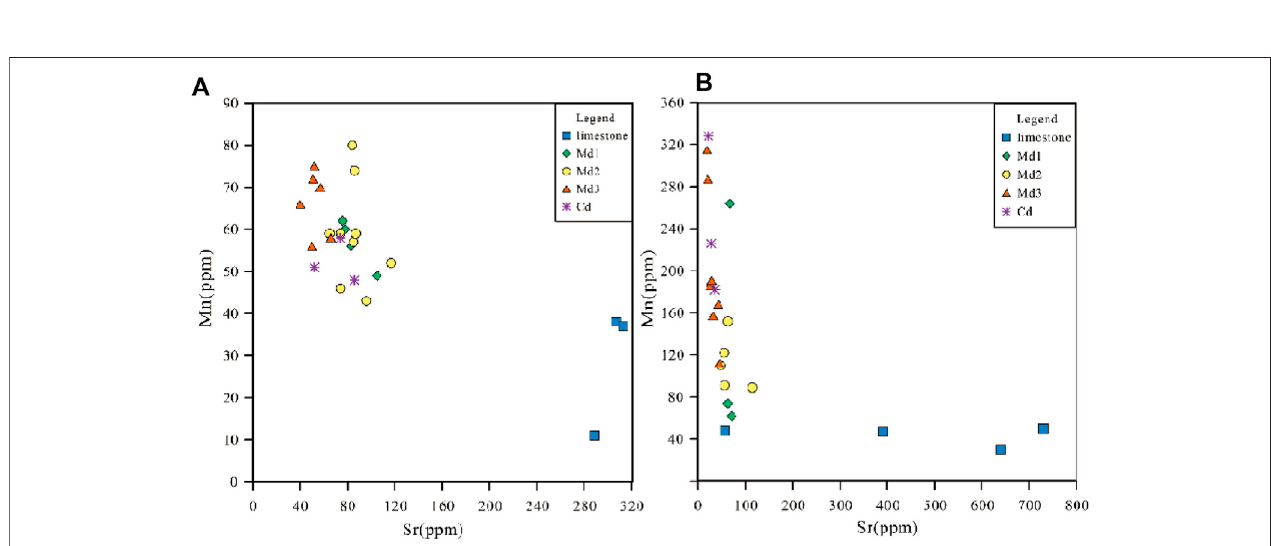
FIGURE 7 | Cross-plot of Sr versus Mn contents in limestones and four types of dolomites. (A) Northwestern (NW) study area; (B) southwestern (SW) study area.